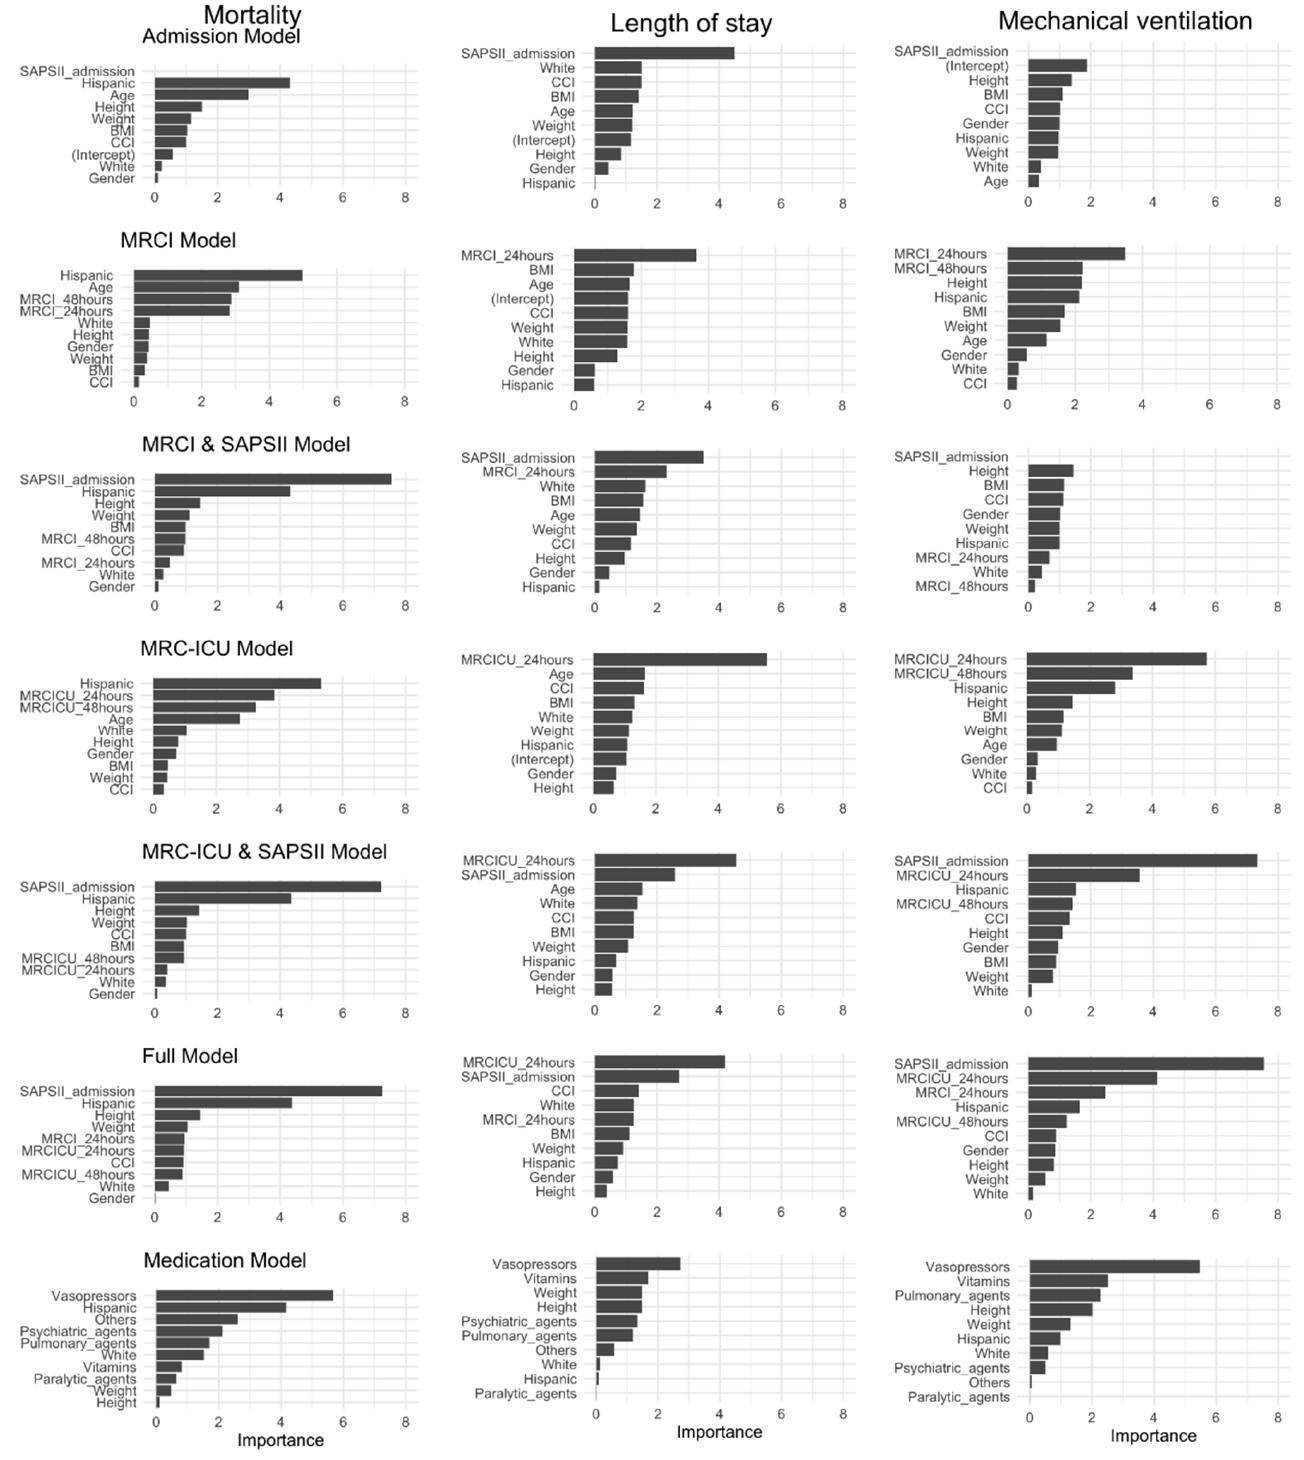
Figure 3. Variable importance of the prediction models. Top 10 variables of importance were ranked for 7 prediction models: ICU mortality ( left panel ), length of ICU stay ( middle panel ), and need for mechanical ventilation ( right panel ).